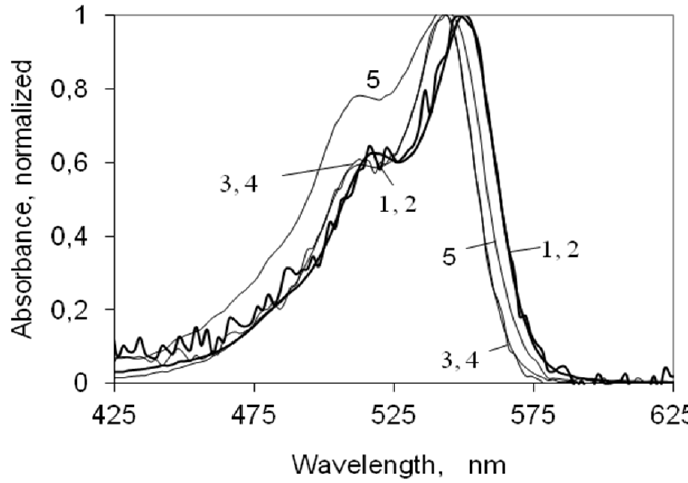
Figure 1. Absorption spectra of the 3,3'-di(2-sulfoethyl)-indocarbocyanine in ethanol (curves 1 and 2) and water (curves 3 to 5), normalized to the absorption maximum. The concentrations for the cyanine dye in ethanol are (1) 1x10 − 7 M (2) 1x10 − 3 M; for the dye